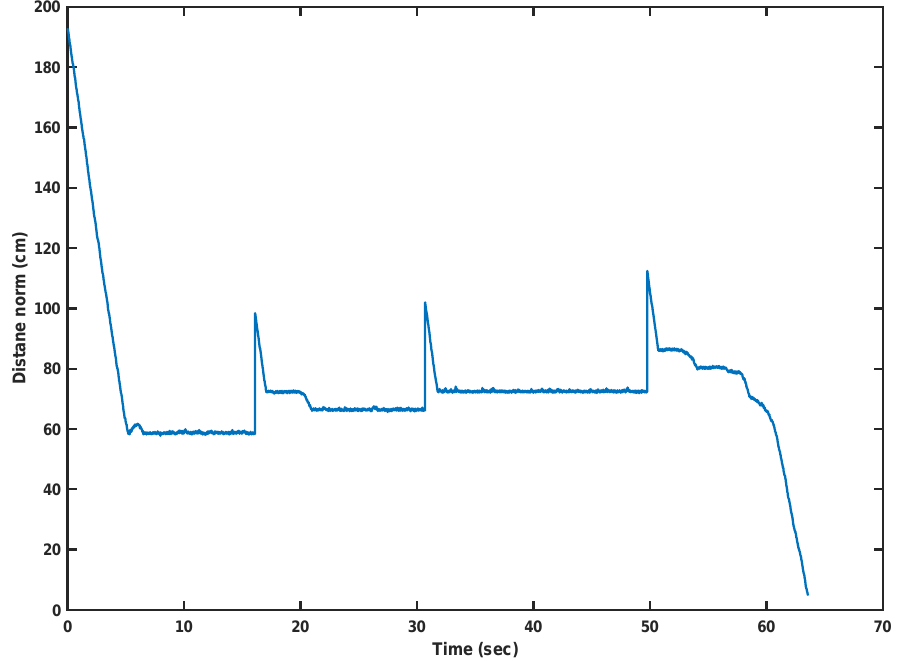
Figure 8. Distance norm calculated between the robot’s position and